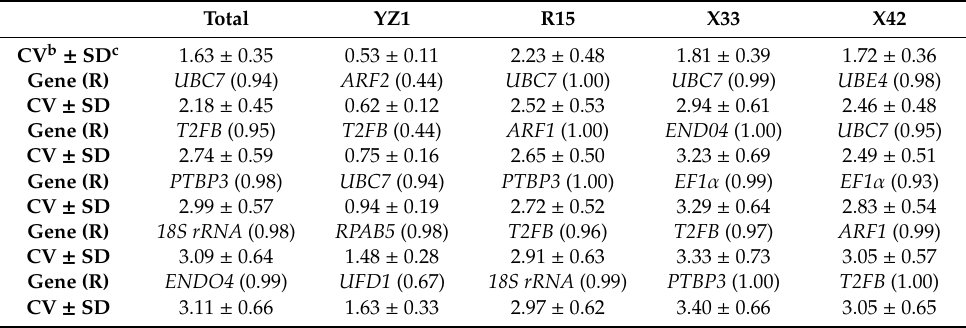
Table 4. Expression stability of the 15 candidate reference genes calculated by